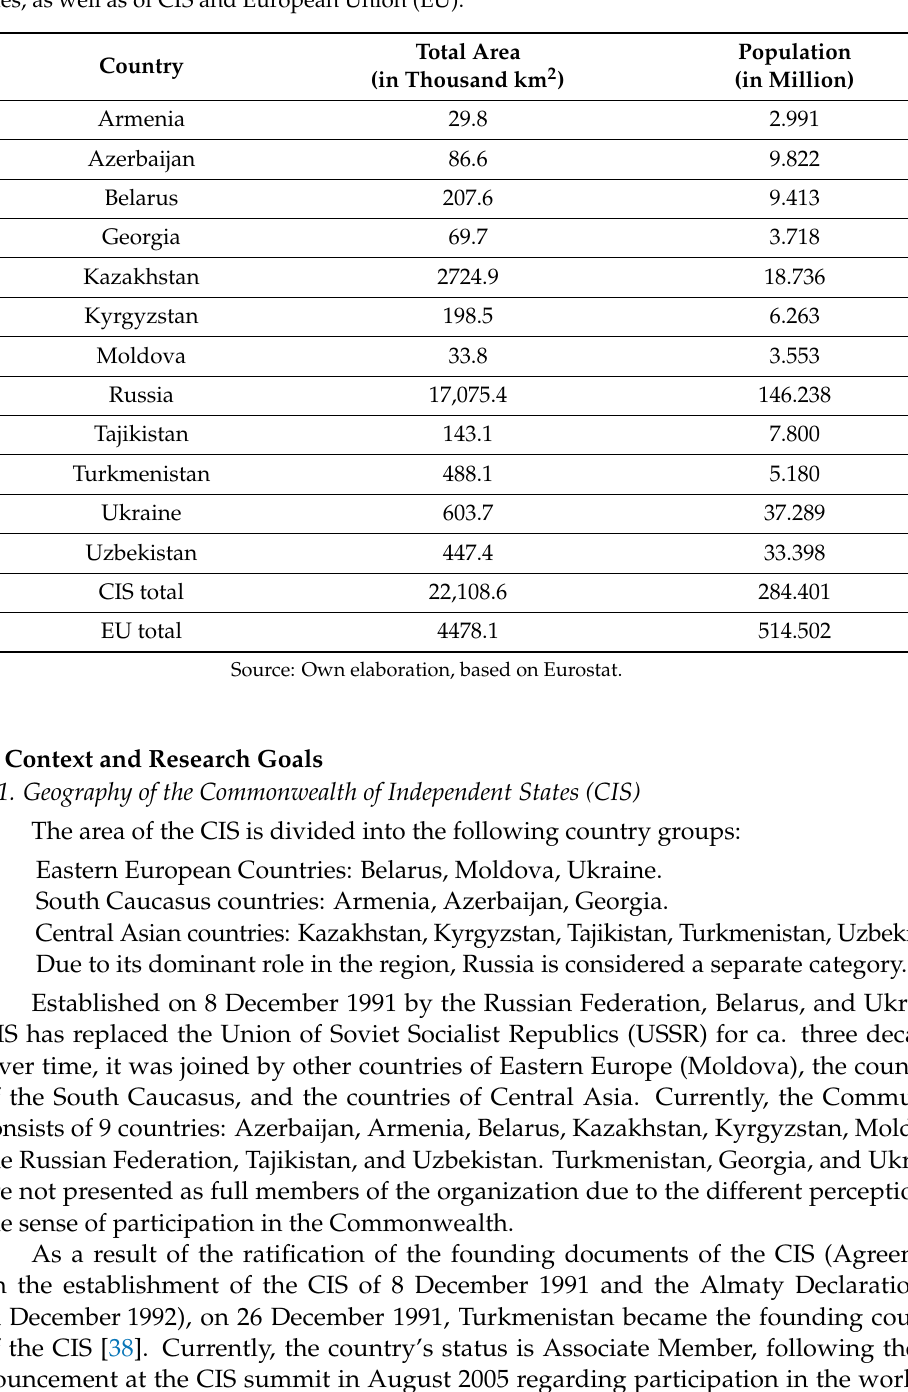
Table 1. Total area and population of individual Commonwealth of Independent States (CIS) coun- tries, as well as of CIS and European Union